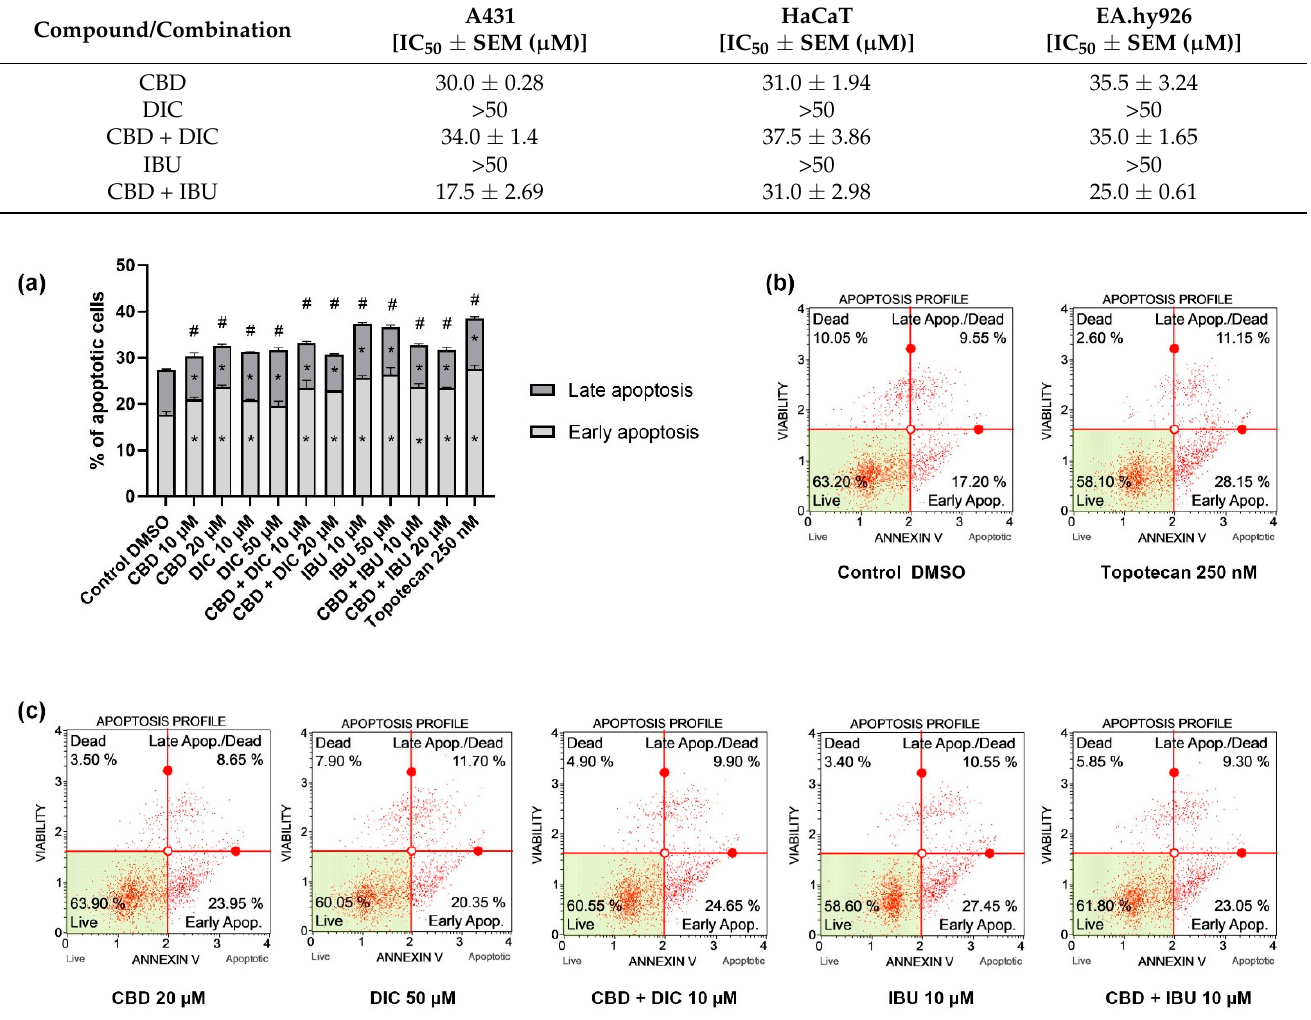
Figure 2. Apoptosis profile obtained using Muse ™ Annexin V & Dead Cell Assay for A431 cells treated with the analyzed compounds (CBD, DIC, IBU) and their equimolar combinations (CBD + DIC, as well as CBD + IBU). The bar chart ( a ) represents the percentage of apoptotic (early and late, as well as total apoptotic) cells after 24 h of treatment with the compounds/combination of compounds. The values are shown as the mean ± SEM calculated from two independent experiments. (*) indicates statistically significant differences from control group for early/late apoptosis, (#) above bar indicates statistically significant differences from control group for total apoptotic cells, p < 0.05. Apoptotic histograms of the negative and positive controls of the assay, i.e., DMSO and 250 nM topotecan, respectively, are presented in ( b ), while the representative samples are shown in ( c ). Four quadrant markers of each plot reflect the different cellular states: the upper left quadrant contains dead cells (necrosis), the upper right has late apoptotic/dead cells (cells that are positive both for Annexin V and for cell death marker 7-AAD, 7-Aminoactinomycin D), the lower left contains live cells and the lower right early apoptotic cells (cells that are positive only for Annexin